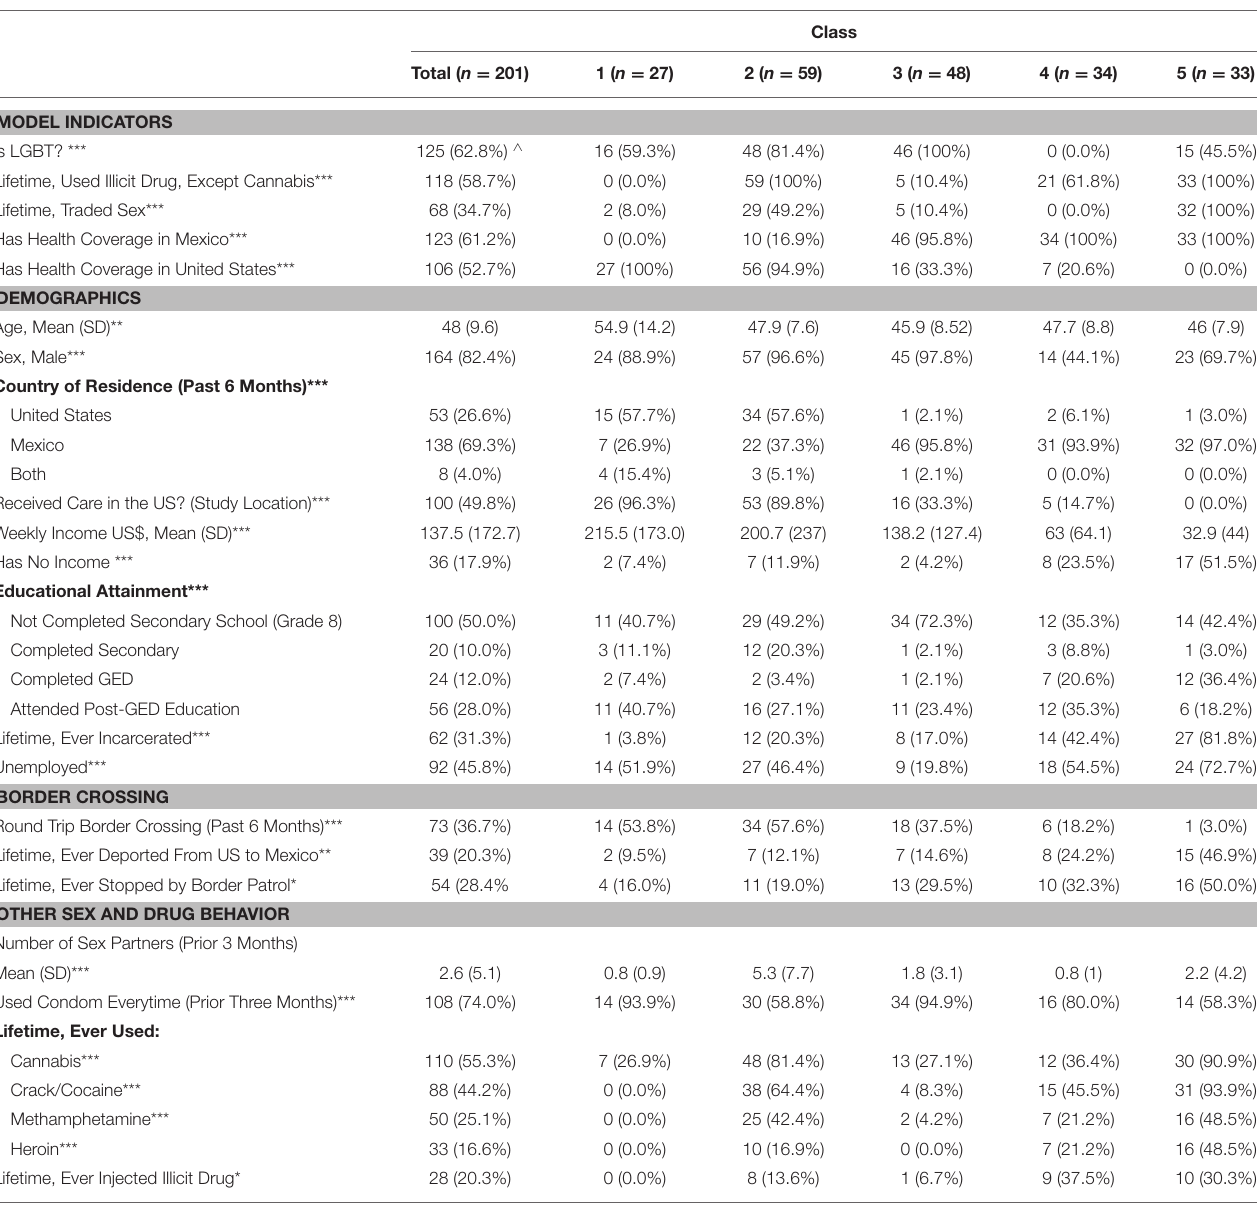
TABLE 2 | Model indicators, demographics, border crossing, and HIV risk behaviors (by